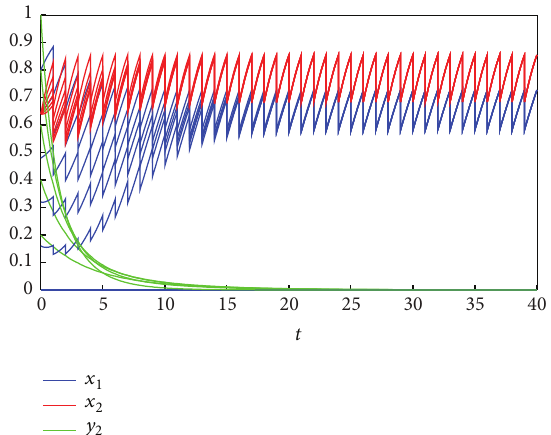
Figure 2: Dynamical behavior of system (3) with different initial values. These initial values are chosen randomly, and other parame- ters are the same as those in Figure 1. One can find that the solutions are globally attractive. The difference between Figures 1 and 2 is that more initial values are chosen in Figure 2 to show that the solutions are globally attractive.